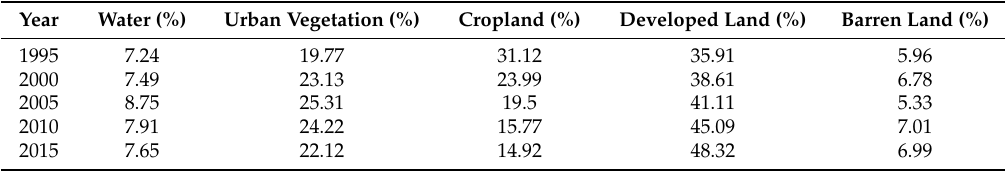
Table 4. Percentages of LCLU types generated by AASG within the east-west transect.